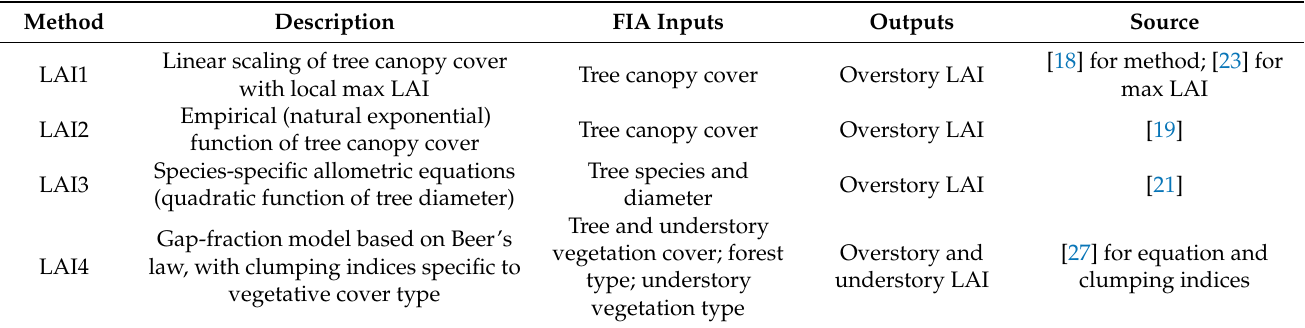
Table 1. Empirical methods used for estimating plot-level LAI at Forest Inventory and Analysis (FIA)